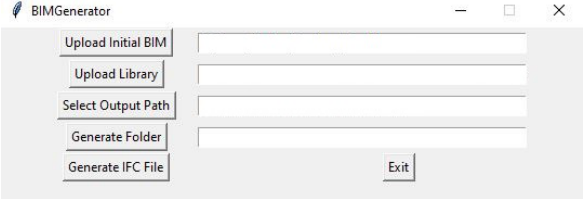
Figure 14. Extracting spatial parameters from individual species identified through the maps and scans.